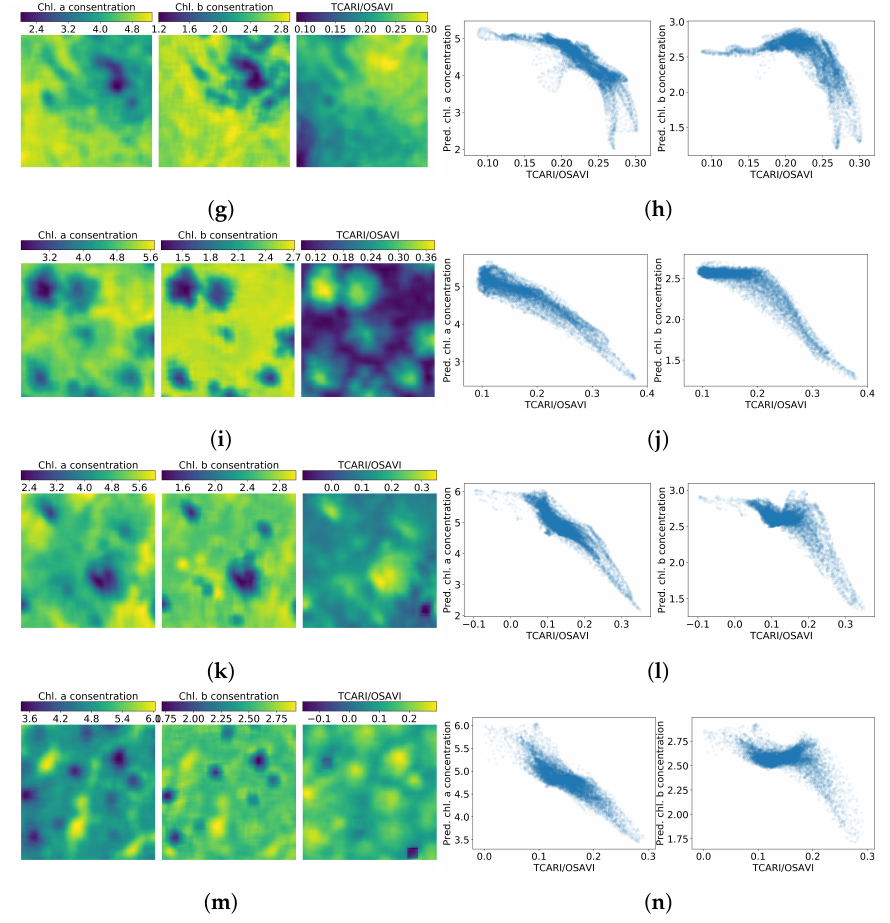
Figure 8. Chlorophyll a , b and TCARI maps (left column) and correlation between the chlorophylls and OSAVI the TCARI index (right column) in plots 1–7. Figures ( a , b ) are related to plot 1, ( c , d ) to plot 2, ( e , f ) to OSAVI plot 3, ( g , h ) to plot 4, ( i , j ) to plot 5, ( k , l ) to plot 6 and ( m , n ) to plot 7. Table 5. Correlation coefficients between predicted chlorophyll values and the TCARI researched